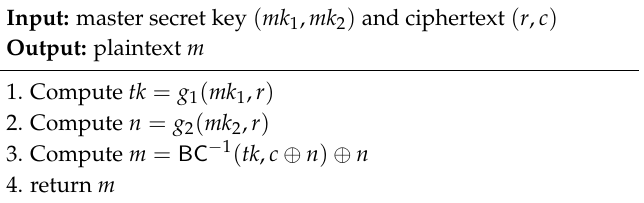
Algorithm 2 First-order SCA-resistant re-keying scheme: dec